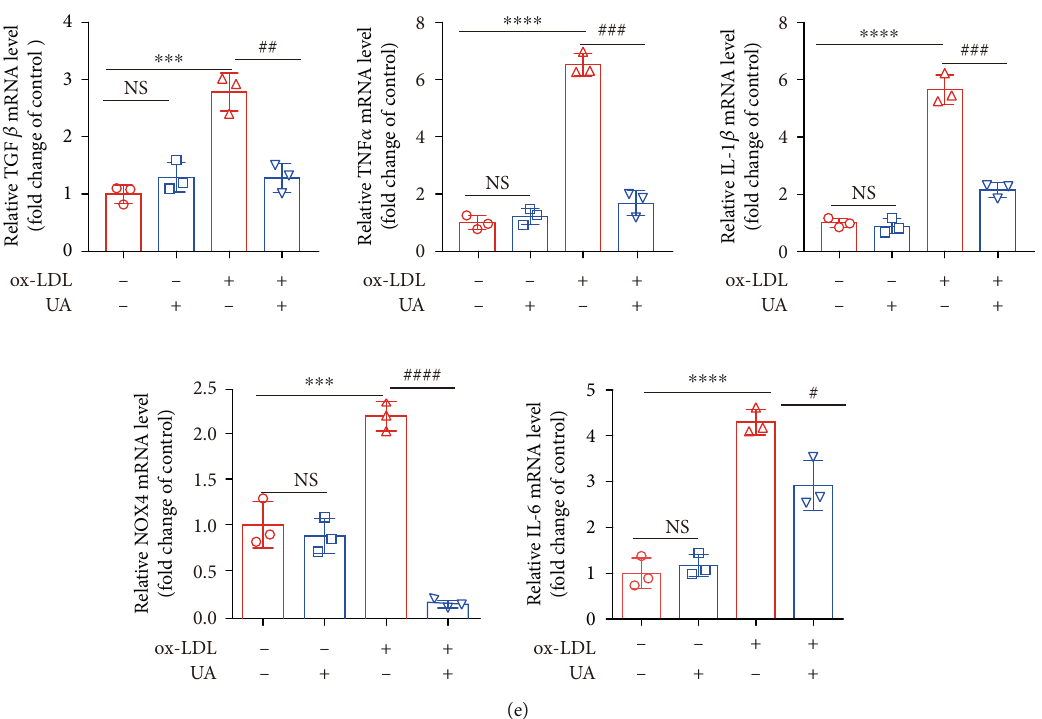
Figure 6: E ff ects of uric acid in micro fl uidic devices on in fl ammation and oxidative stress caused by ox-LDL in HUVECs. (a) Schematic diagram of vascular endothelial cells. (b) Photograph of a prototype. (c) A schematic diagram of cells in the micro chambers. (d) The micro fl uidic chambers were perfused with medium containing red THP-1 cells at velocity of 5 μ L/min. HUVECs were stained by Mito- Green, determined by green fl uorescence. Scale bar = 200 μ m. (e) The mRNA levels of TGF β , TNF α , IL-1 β , IL-6, and Nox4 were assessed by reserve transcription PCR. GAPDH served as loading controls. Group data were obtained by normalizing to GAPDH and expressed as fold of control values. The statistical analyses were done using GraphPad Prism V-7.0 software. Data are expressed as the mean ± standard deviation ( n = 3 ). One-way ANOVA was used in statistical analyses ( n = 3 /group). ∗ P < 0 : 05 , ∗∗ P < 0 : 01 , ∗∗∗ P < 0 : 001 , and ∗∗∗∗ P < 0 : 0001 versus the control. # P < 0 : 05 , ## P < 0 : 01 , ### P < 0 : 001 , and #### P < 0 : 0001 versus the ox-LDL group.